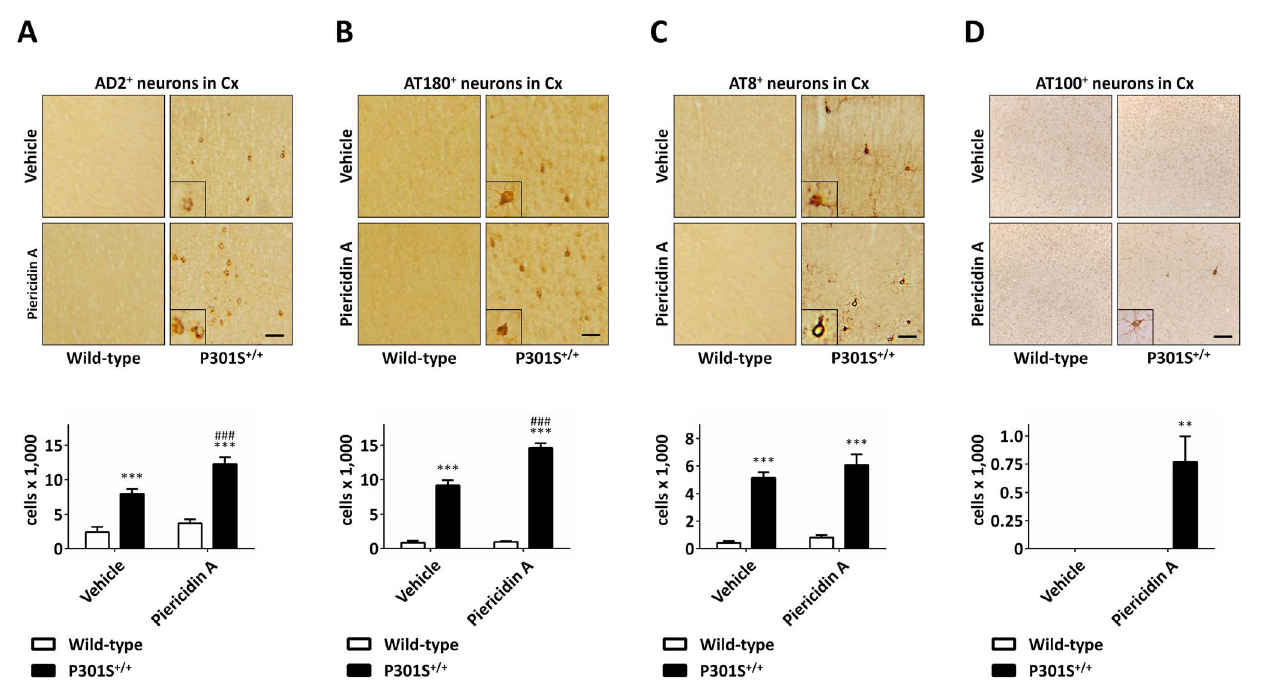
Figure 3. Histological sections showing the effect of piericidin A treatment on tau pathology. Frontal cortex (Cx) of wild-type and P301S + / + mice treated with vehicle or piericidin A. Sections were stained separately with the antibodies AD2 (A), AT 180 (B), AT8 (C), and AT100 (D). The inserts are 2.5- times magnified compared to the overview images. P301S + / + mice had significant higher numbers of phospho-tau positive cells in the frontal cortex compared to wild-type animals with the same treatment (lower panels, filled bars). Treatment with piericidin A further increased the number of AD2 immunoreactive cells (A, lower panel) and AT180 immunoreactive cells (B, lower panel). With AT8 immunoreactivity there was the same tendency, however, the difference was not significant (C, lower panel). With the AT100 antibody we only observed immunoreactive cells in piericidin A treated P301S + / + mice (D). Scale bars: 20 m m. * p , 0.05, ** p , 0.01, *** p , 0.001, P301S + / + vs. wild-type at the same treatment. # p , 0.05, ## p , 0.01, ### p , 0.001, piericidin A treatment vs. vehicle treatment at the same genotype. Two-way ANOVA with Fisher LSD post-hoc